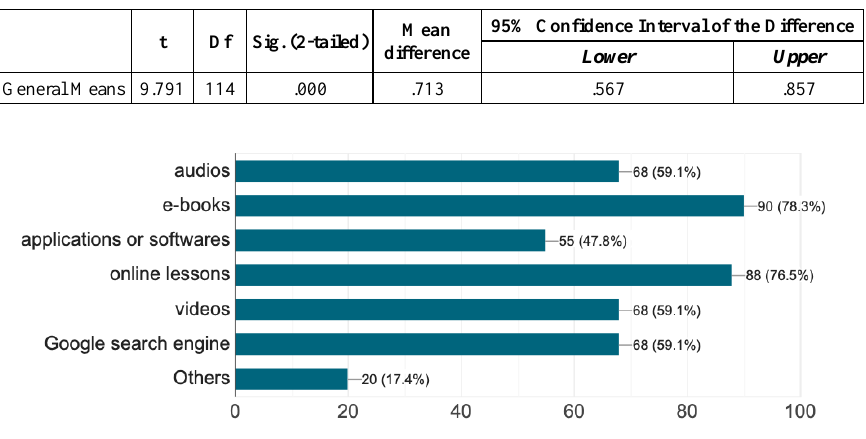
Fig. 1. Participants’ means of interaction with the subject